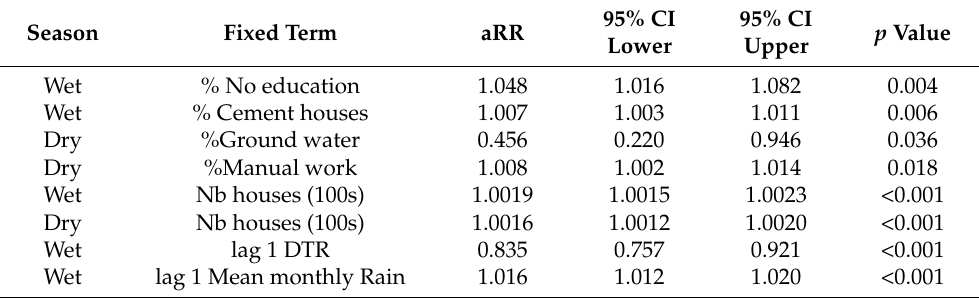
Table A4. Association of socio-economic variables, meteorological factors, and year with dengue cases in the final adequate multivariable GLMM model.